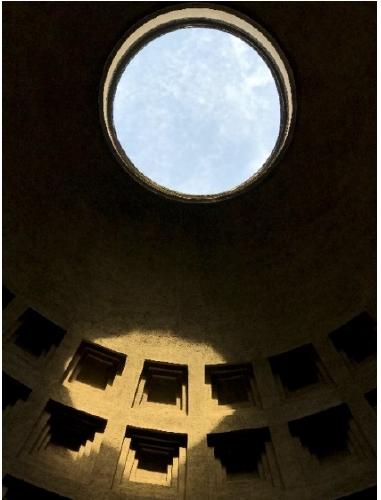
Figure 1. The Oculus in the Pantheon, Rome. Source: